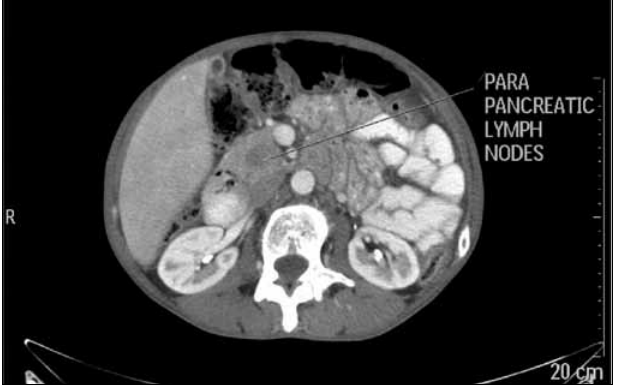
Fig. 3. Axial post-contrast CT scan, venous phase at the level of the kidneys, showing large para-pancreatic lymph nodes with central